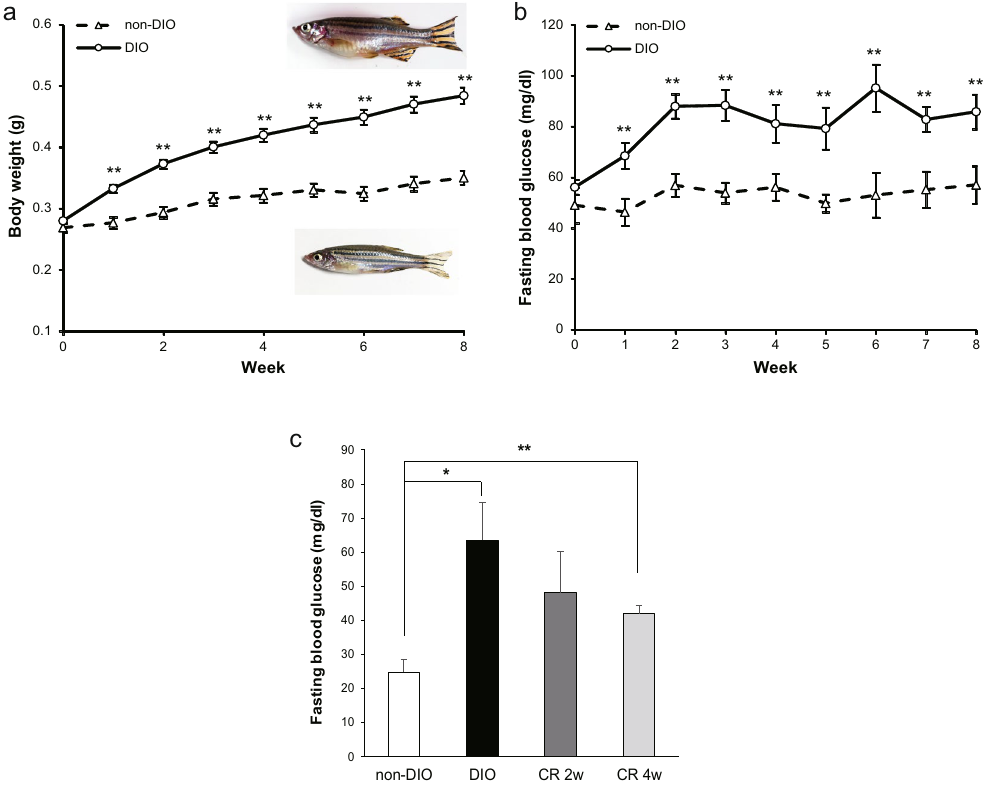
Figure 1. Body weights (g), fasting blood glucose of overfed (DIO) and normal-fed (non-DIO) zebrafish, and effect of calorie restriction on DIO zebrafish. ( a ) DIO zebrafish gain weight progressively over an 8-week period. Representative images of DIO (upper) and non-DIO (lower) zebrafish are shown in the panel. Non-DIO group: n = 14; DIO group: n = 29. ( b ) Changes in the fasting blood glucose concentrations of the non-DIO and DIO groups. Non-DIO group: n = 14; DIO group: n = 29. ( c ) Changes in fasting blood glucose concentrations after calorie restriction for 2 and 4 weeks. n = 5–8. Values are means ± SE. * P < 0.05, ** P < 0.01 vs. the non-DIO group.